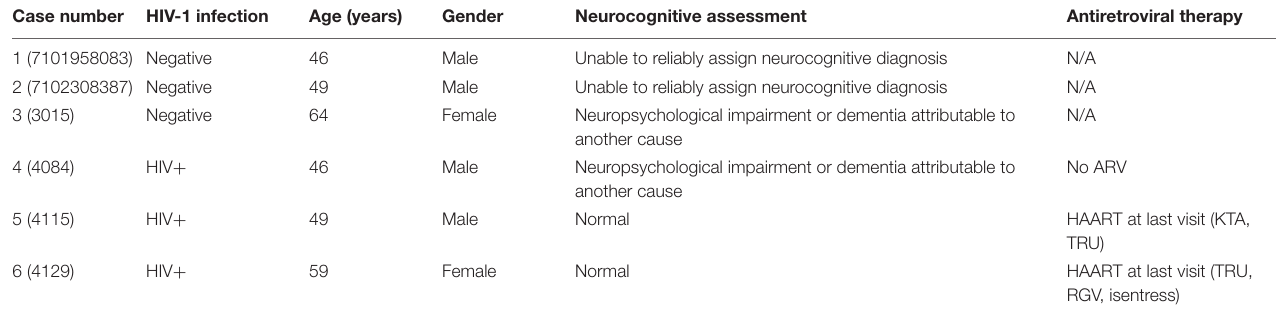
TABLE 1 | Clinical characteristics of the patients included in this